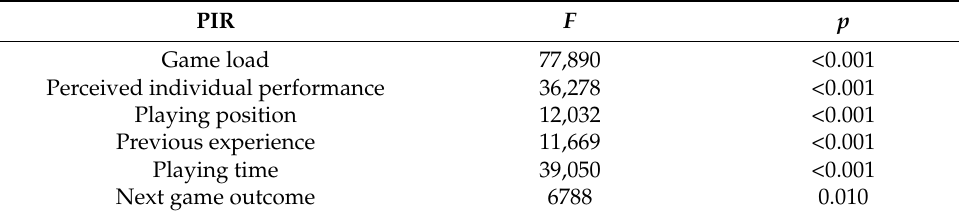
Table 5. Main significant effects on the PIR.